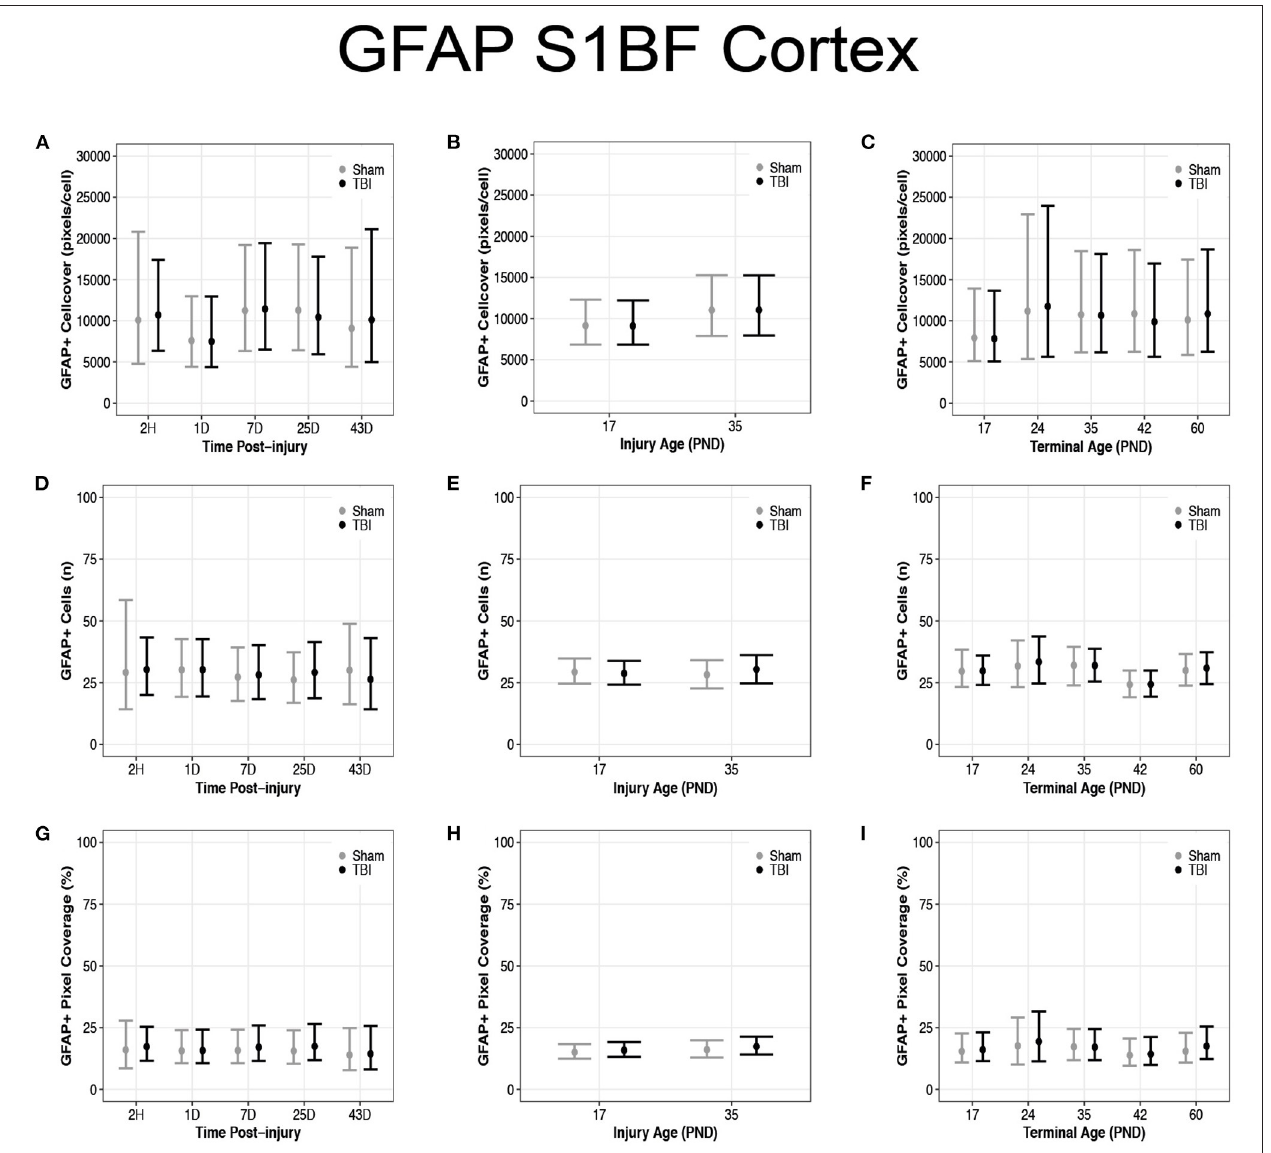
FIGURE 8 | Diffuse TBI did not affect GFAP expression in the S1BF. Point estimates (posterior means) and corresponding 95% credible intervals (highest posterior density intervals) are presented. (A–C) There were no differences in cell coverage between sham and TBI rats across times post-injury, injury ages, and terminal ages. (D,E) There were no differences in the number of GFAP + cells between sham and TBI rats across times post-injury or injury ages, (F) however, at terminal age PND42, both sham and TBI rats had fewer GFAP + cells than other terminal ages. (G–I) Sham and TBI rats had similar pixel coverage values across terminal ages, injury ages, and times